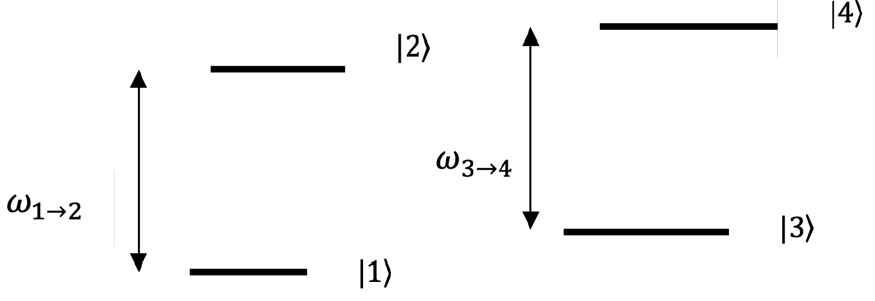
Figure 2. Basic setup for the one-qubit operation.